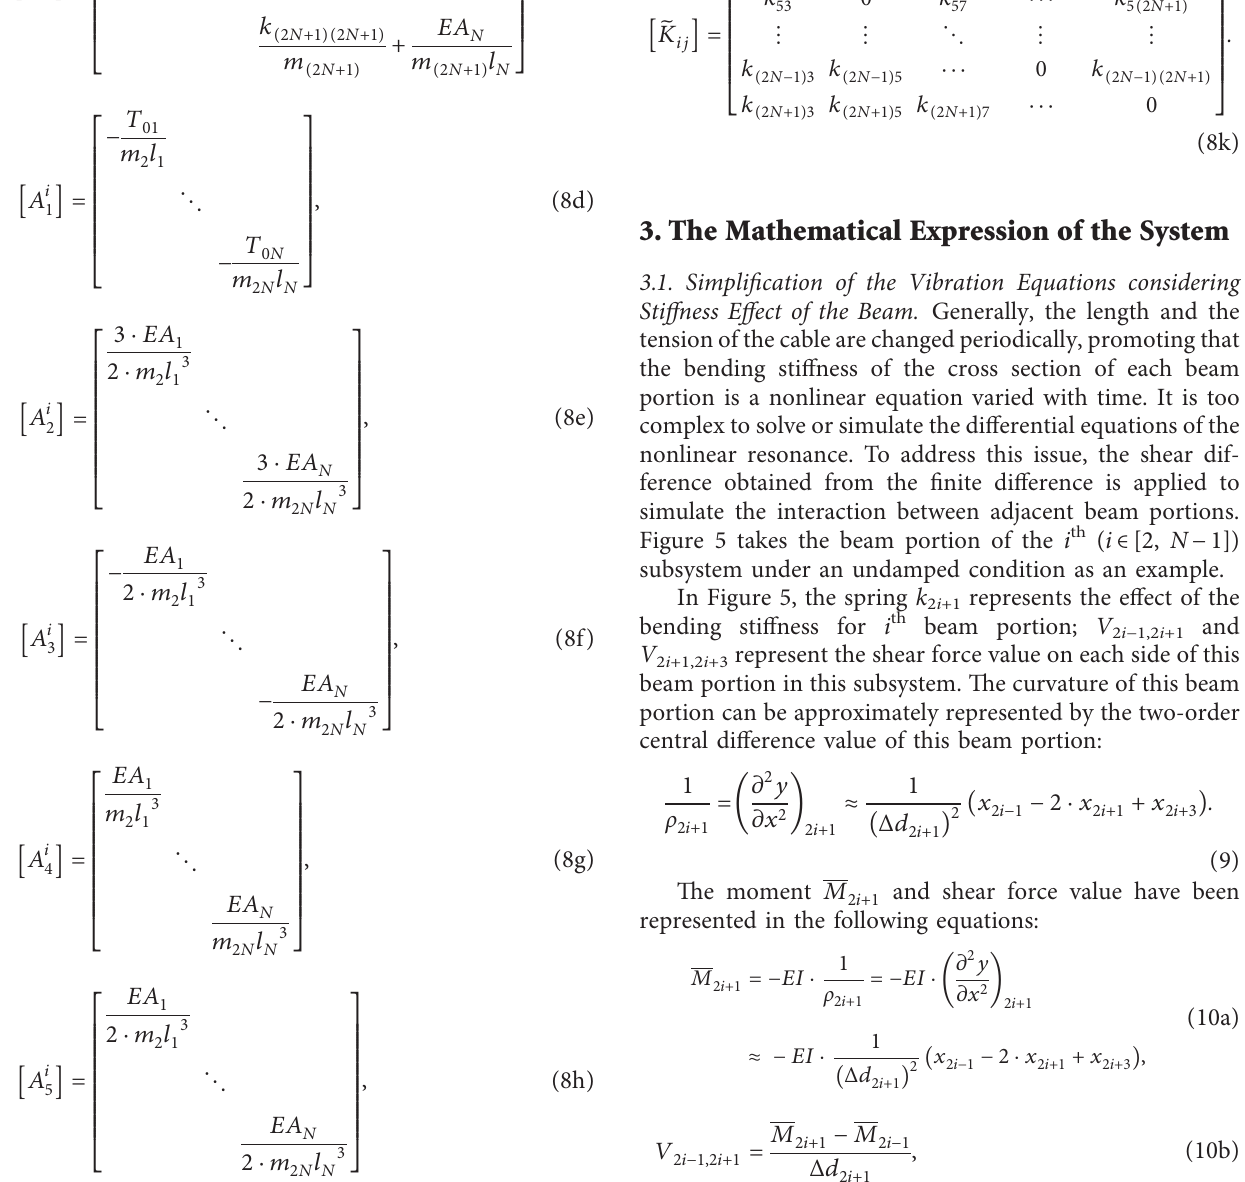
The moment M and shear force value have been 2 i + 1 represented in the following